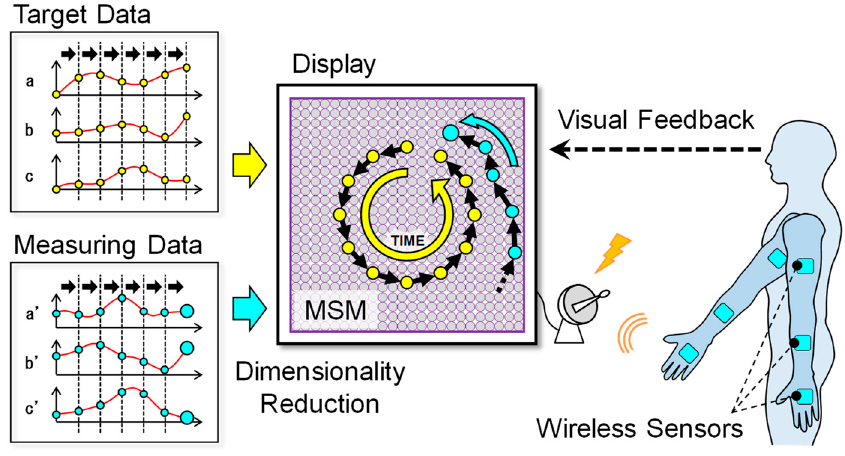
Figure 1. Proposed framework for visual-feedback training in cyclic motion using the modified self- organizing map (SOM) algorithm. To apply the SOM algorithm, the target circle was projected prior to training, and the subject’s trajectories were projected successively by measuring and displaying his motion in real